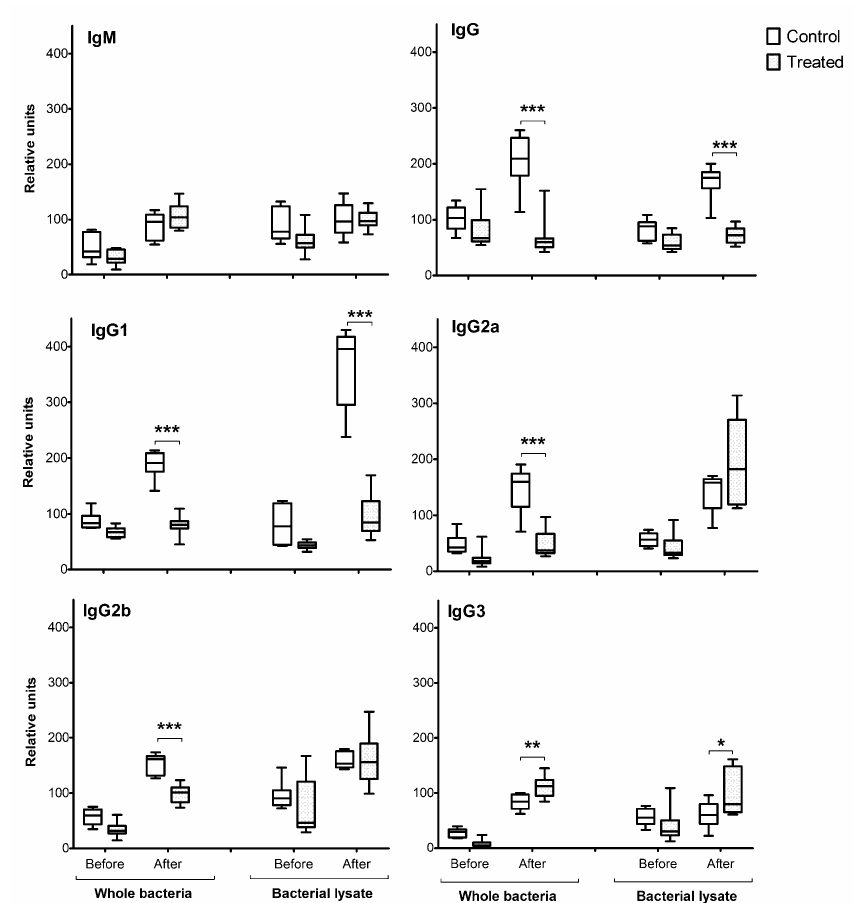
Figure 7. Relative units of immunoglobulin G isotypes IgG1, IgG2a, IgG2b and IgG3 antibodies in blood sera of the control (PEF untreated) and PEF-treated (3 kV, 1.2 mm gap) mice. Whole bacteria graphs represent the amounts of antibodies produced against surface antigens of P. aeruginosa and bacterial lysate against intracellular antigens. The white columns represent the antibody levels detected in the blood sera of control mice, and the gray columns represent the PEF-treated ones. Asterisk (*) corresponds to statistically significant differences (* p ≤ 0.05; ** p ≤ 0.01; *** p ≤ 0.001). As can be seen, the relative units of surface and intracellular IgM Ab in control and